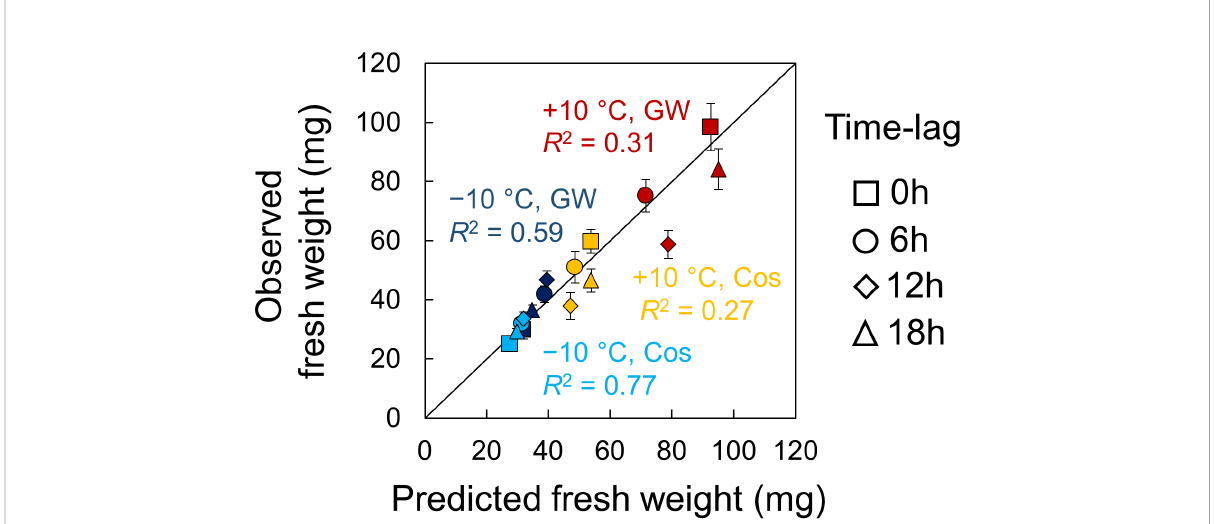
FIGURE 7 Prediction of fresh weight of leaf lettuce ( Lactuca sativa L.) by the simulation based on the entrainment properties of circadian clock. Error bars indicate standard error. The value of R 2 indicates the coef fi cient of determination for the line with a slope of